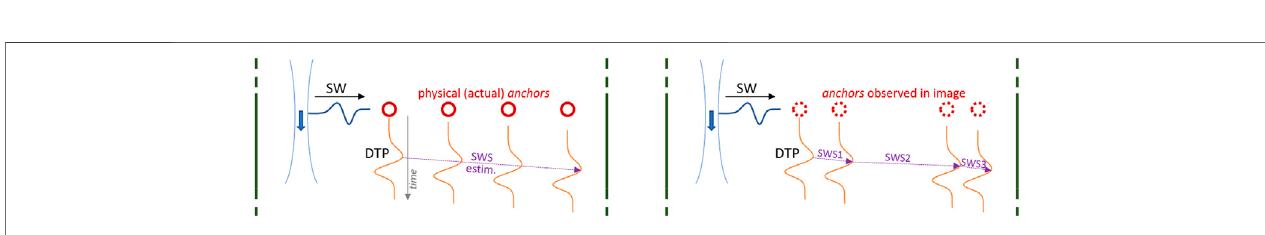
FIGURE 6 | Illustration of simulation. A given SWS encountered as displacement-time pro fi les (DTPs) at physical anchor (scatterer) location (left) may appear as a different SWS if the same DTPs are observed at different image locations (right), e.g., due to aberrations in beamforming.